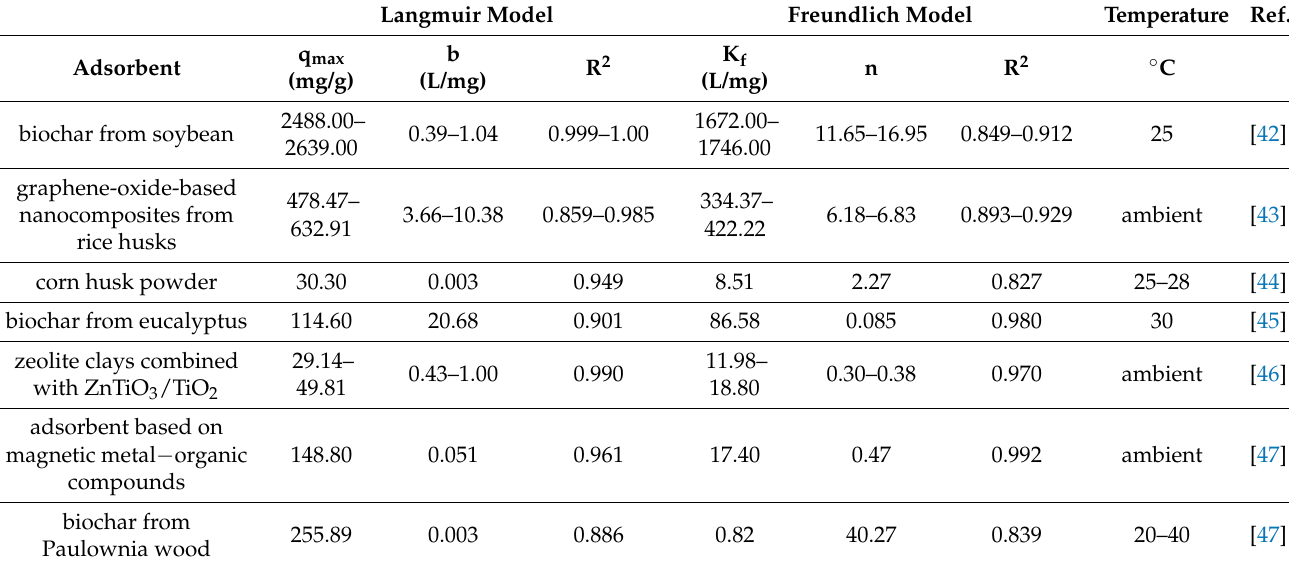
Table 8. Performances of some non-commercial adsorbents tested for the removal of methylene blue. Langmuir Model Freundlich Model Temperature